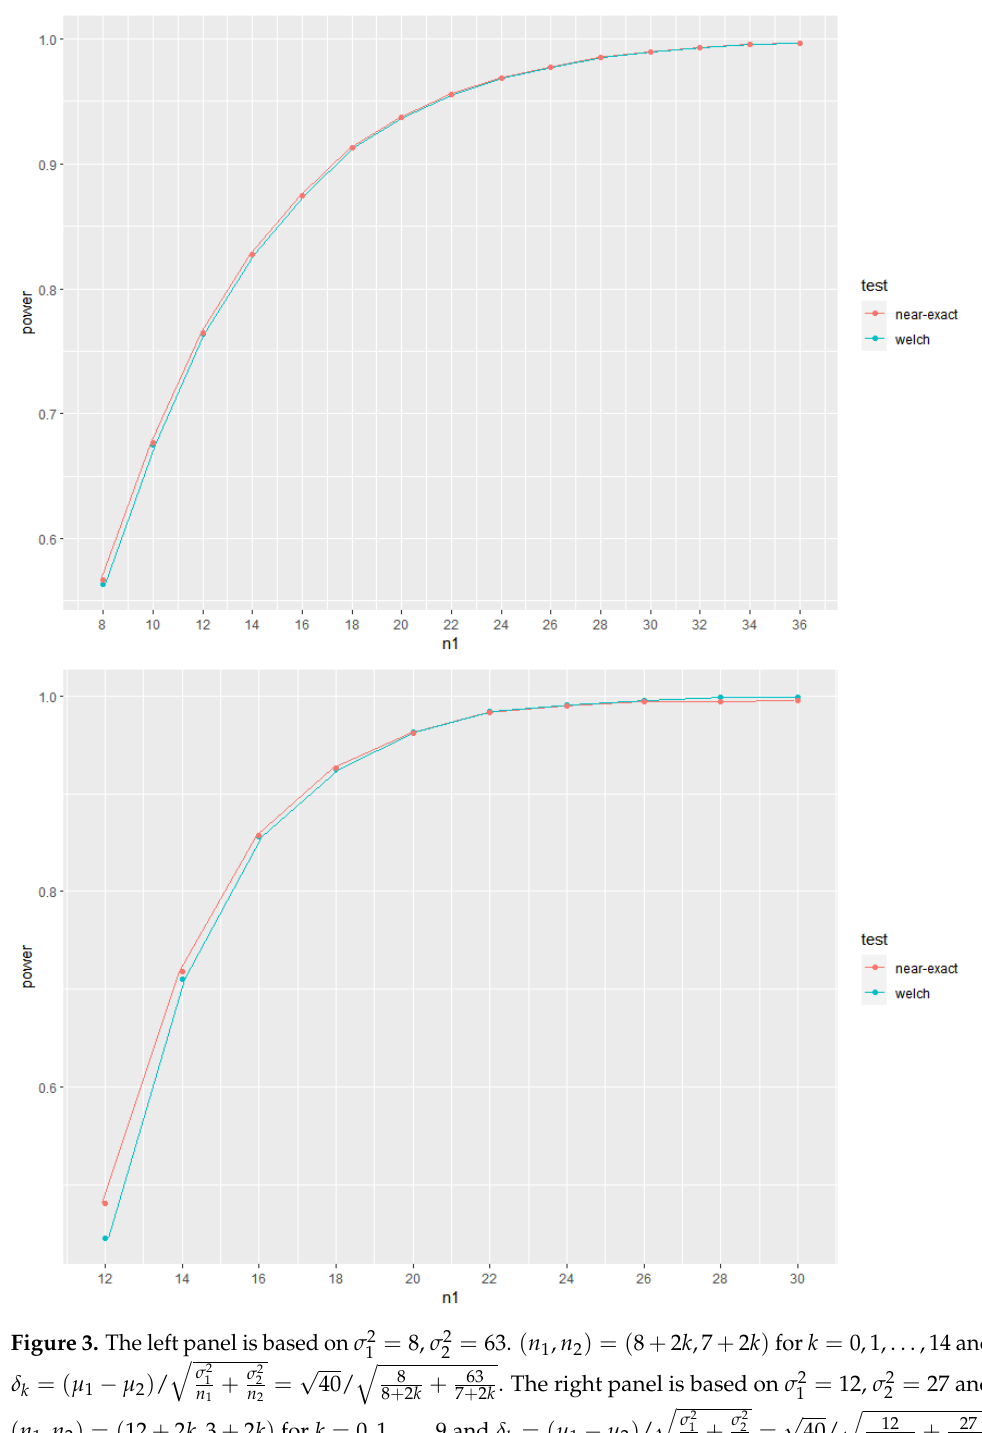
Figure 3. The left panel is based on σ 2 δ k = ( µ 1 − µ 2 ) / ( n ) = ( 12 + 2 k ,3 + 2 k ) for k = 0,1, . . . ,9 and δ 1 , n 2 Red and blue lines represent the power curves from the nearly exact distribution and Welch’s test,